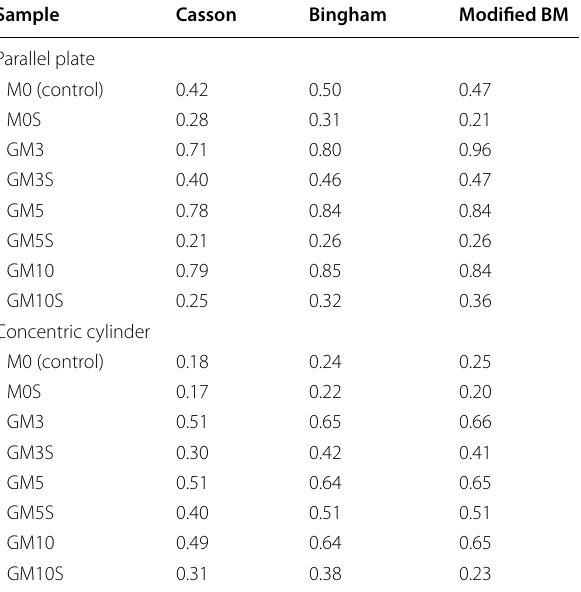
Table 13 Influence of superplasticizer on plastic